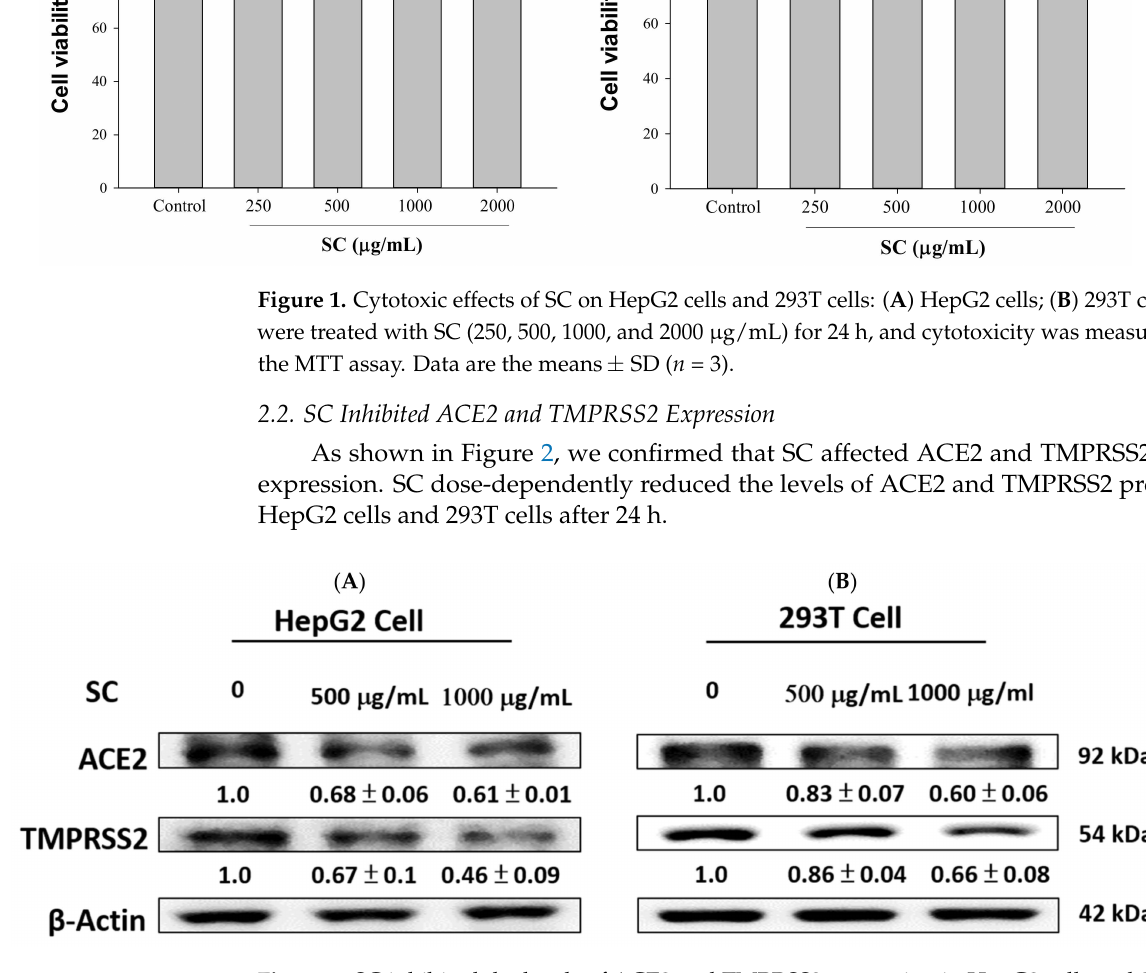
Figure 2. SC inhibited the levels of ACE2 and TMPRSS2 expression in HepG2 cells and 293T cells. HepG2 ( A ) and 293T ( B ) cells were treated with SC (500 and 1000 µ g/mL) for 24 h, and the protein expression was measured using Western blot. The densitometric analysis of protein bands is presented as a ratio (SC/control). β -actin was used as the positive